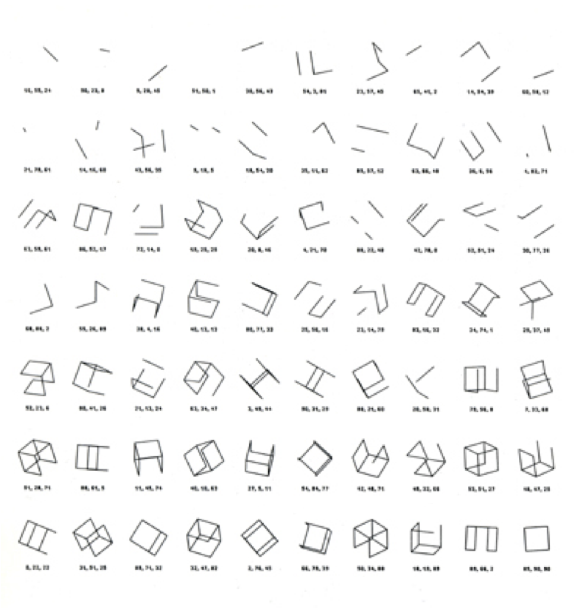
Figure 1 | Manfred Mohr, P-154-C1 , 1973, Courtesy of the